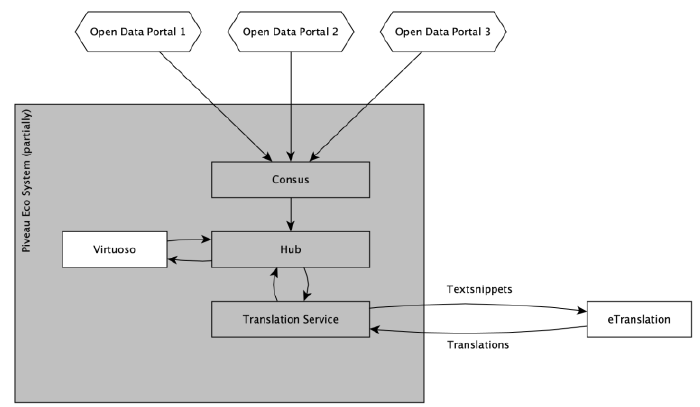
Figure 3: Partial overview of the Piveau